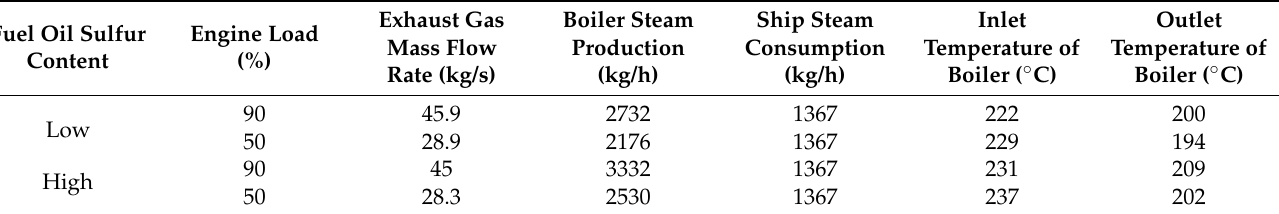
Table 5. Exhaust gas parameters at the outlet of the boiler in summer.